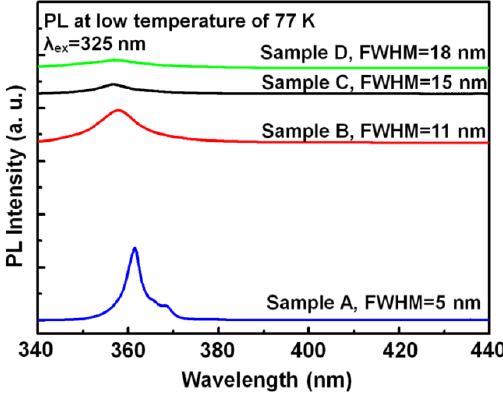
Figure 1. Low ‐ temperature photoluminescence (PL) spectra (at 77 K) of GaN films grown on different substrates. FWHM: full width at half maximum.